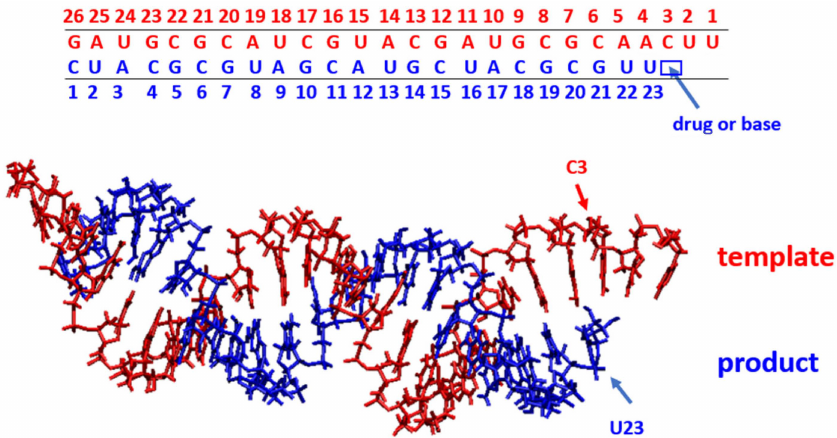
Figure 1. Sequence (top) and structure (bottom) of the dsRNA, template (red) and product (blue), used in the MD simulations of the complex with unbound and bound (in +1 position) drug or base.